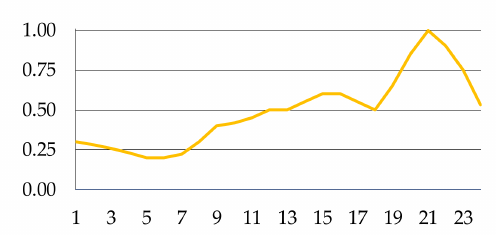
Figure 2. The daily load profile (p.u. of peak load) of residential loads in the CIGRE test network.